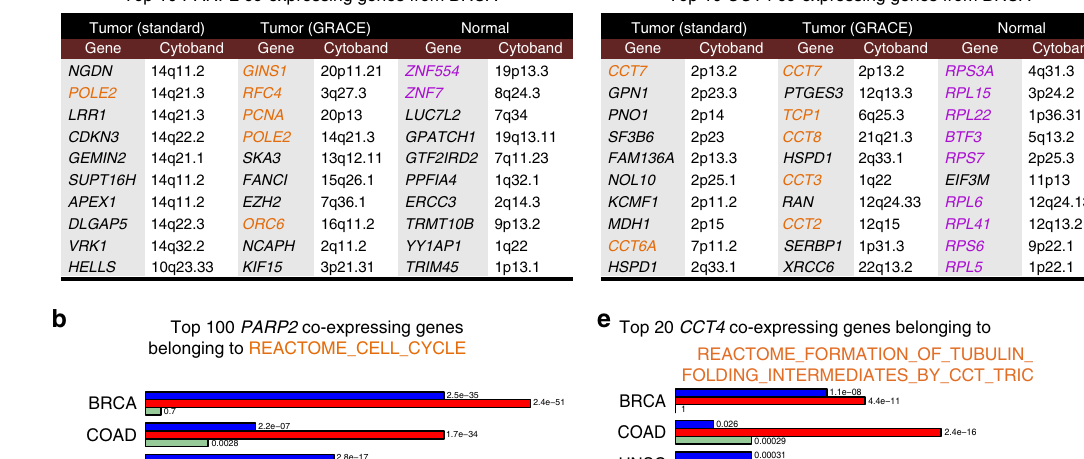
co-expressing genes ( e ) or “ KEGG_RIBOSOME ” ( f ) in top 100 CCT4 co-expressing genes. Analyses are based on TCGA BRCA data. P values from hypergeometric tests were given next to the bars. Abbreviations for TCGA cohorts: BRCA breast invasive carcinoma, COAD colon adenocarcinoma, HNSC head and neck squamous cell carcinoma, KICH kidney chromophobe, KIRC kidney renal clear cell carcinoma, KIRP kidney renal clear cell carcinoma, LIHC liver hepatocellular carcinoma, LUAD lung adenocarcinoma, LUSC lung squamous cell carcinoma, PRAD prostate